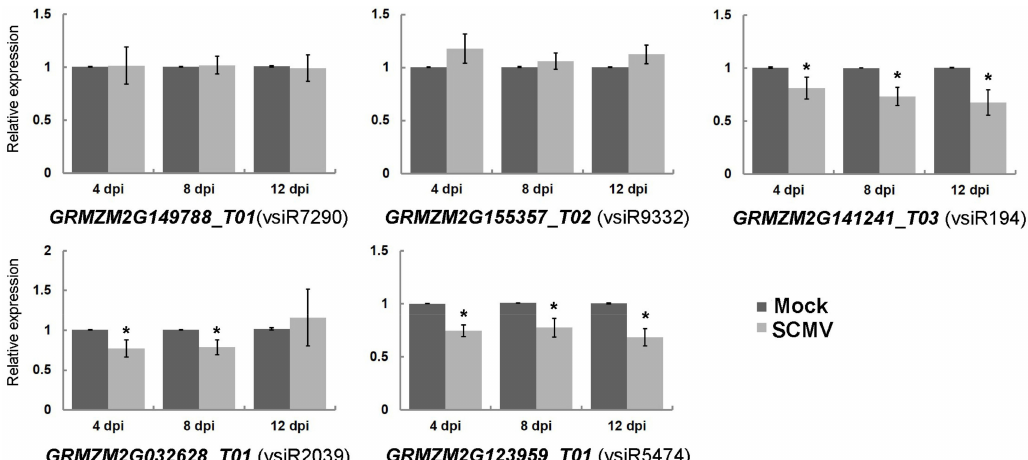
Figure 2. The expression of maize transcripts targeted by vsiRNAs in Mock- and SCMV-inoculated maize plants. The expression levels of the indicated target genes were determined by qRT-PCR at 4 dpi, 8 dpi and 12 dpi, respectively. Three independent experiments were conducted with at least three biological replicates each and the data were analyzed using a two-sample t -test. An asterisk indicates a significant difference ( p -value < 0.05). Bars represent the means ± SD.